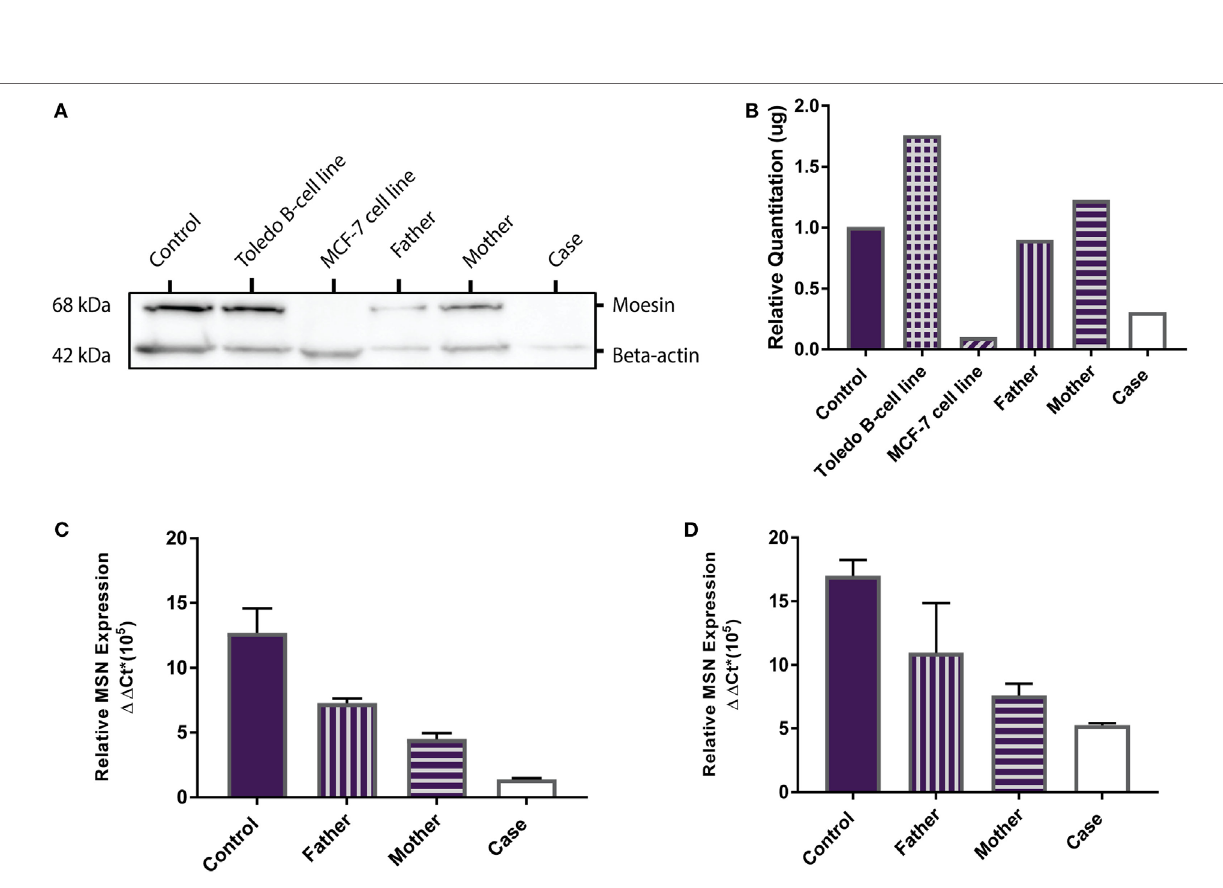
FIGURe 2 | MSN protein detection and MSN gene expression. (a) Western Blot shows absence of the 68 kDa moesin protein in the MCF-7 cell line (negative control, lane 3) and in the proband (lane 6), and presence of moesin in the healthy control subject (lane 1), Toledo B-cell line (positive control, lane 2), father (lane 4), and mother (lane 5). Beta-actin (42 kDa) was used as the loading control. (B) Optical density protein quantitation software showed very low levels of moesin ( < 0.5 μ g) in the MCF-7 cells and the proband, confirming a moesin deficiency. (C) qPCR analysis of MSN mRNA transcript levels in whole blood (PAXgene) from the control subject, father, mother and proband. Error bars depict standard error of the mean (SEM) between triplicates. (D) qPCR analysis of MSN mRNA transcript levels in lymphocytes from the control subject, father, mother, and case. Error bars depict SEM between triplicates.